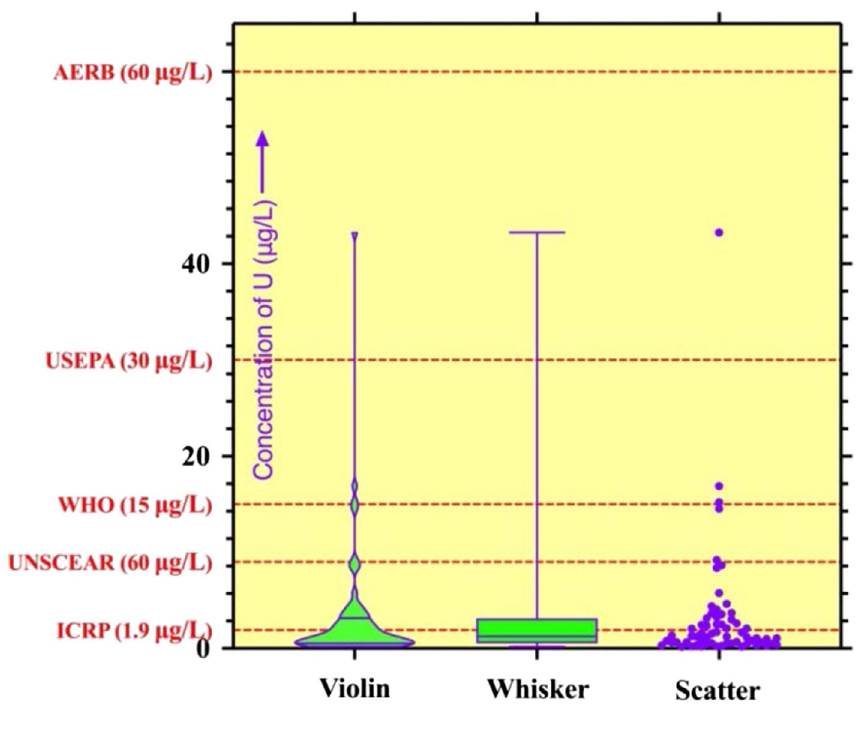
Fig. 11 Distribution of uranium concentration in the samples